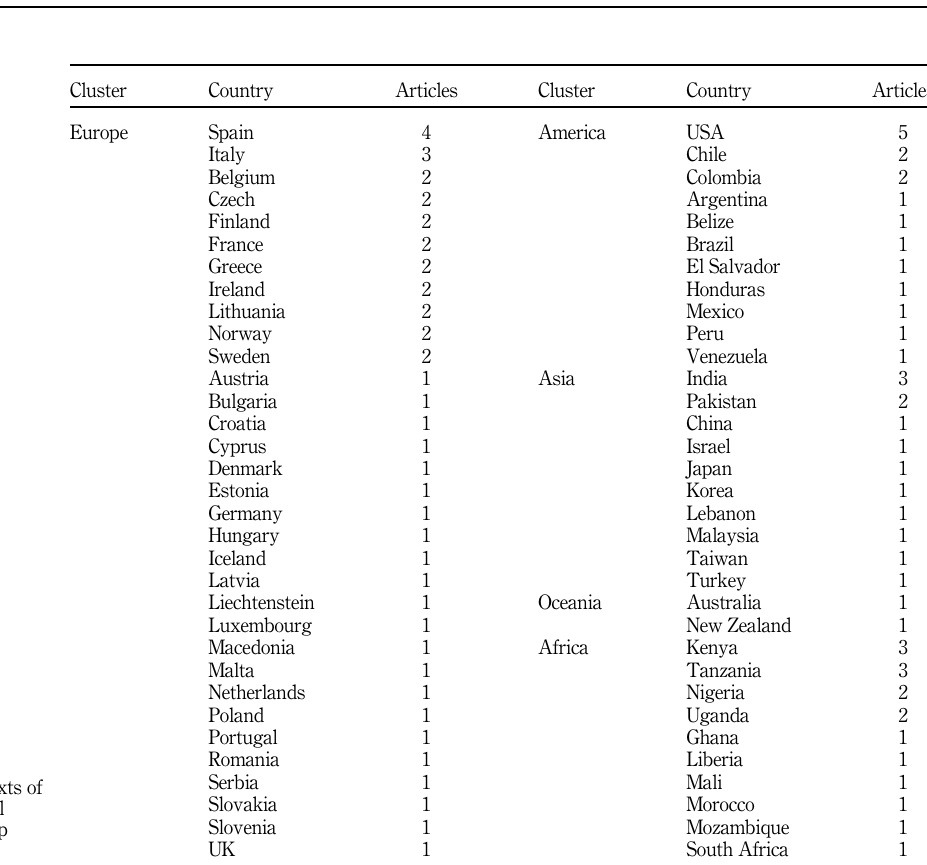
Table 2. Empirical contexts of articles on social entrepreneurship in